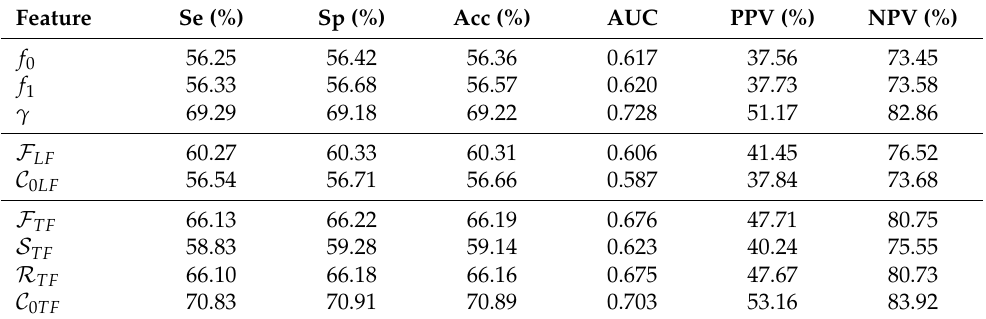
Table 3. Classification between patients who relapsed to AF and maintained SR during the follow-up based on the most-predictive single parameters.